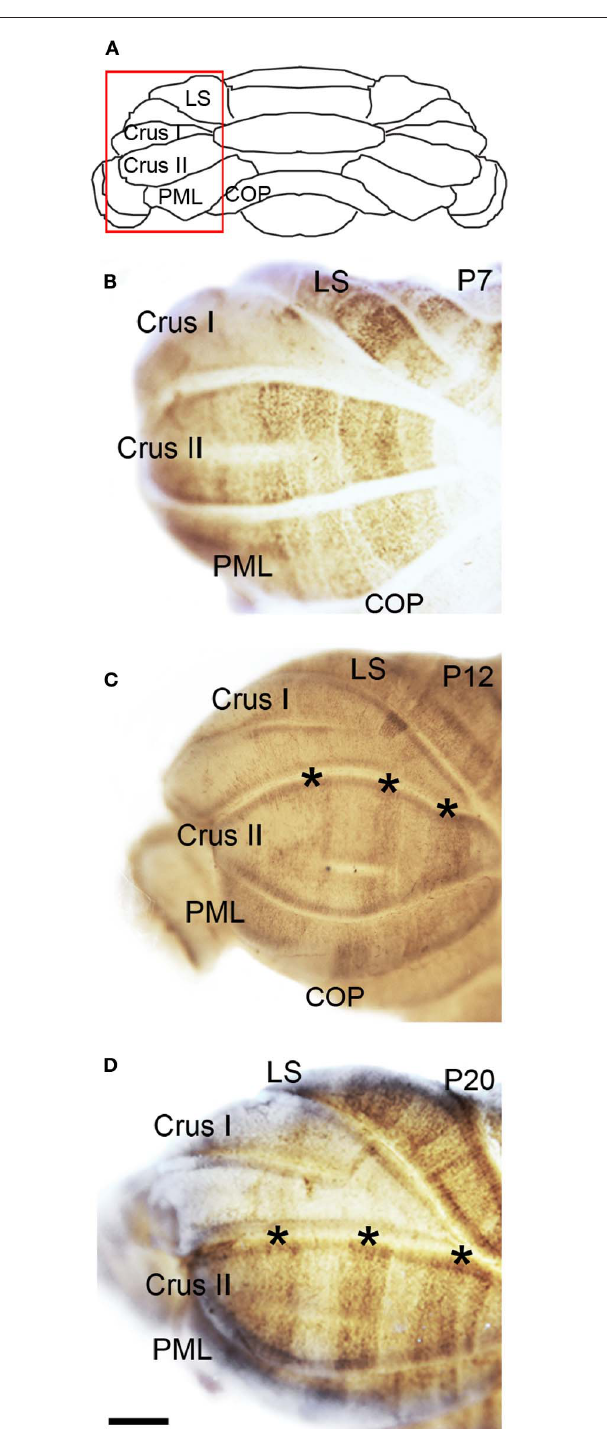
FIGURE 5 | NFH zone boundaries are sharpened in the developing hemispheres. (A) Schematic indicating the region of the hemisphere that is shown in panels (B–D) . (B) NFH expression reveals a raphe-like pattern in Crus II at P7. (C) By P12, the NFH pattern consists of clear-cut zones (asterisks in C and D ). (D) The overall pattern at P20 is identical to P12, although each zone is now sharply delineated. Abbreviation: LS, lobulus simplex; PML, paramedian lobule; COP, copula pyramidis. Scale bar = 500 μ